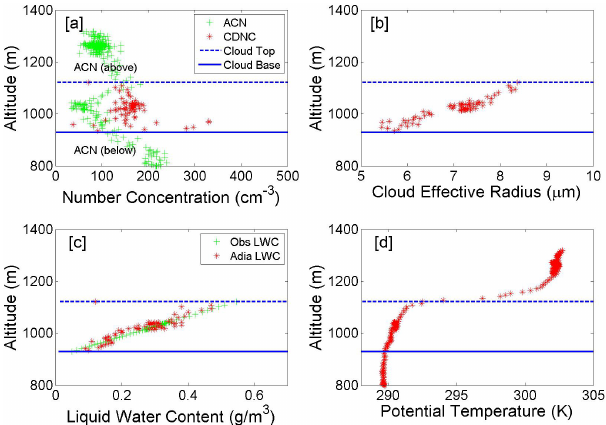
Fig. 1. Vertical distribution of aerosol concentration number (ACN), cloud drop number concentration (CDNC), cloud effective radius ( R e ), cloud liquid water content (LWC), and atmospheric tempera- ture measured by G-1 on 6 November